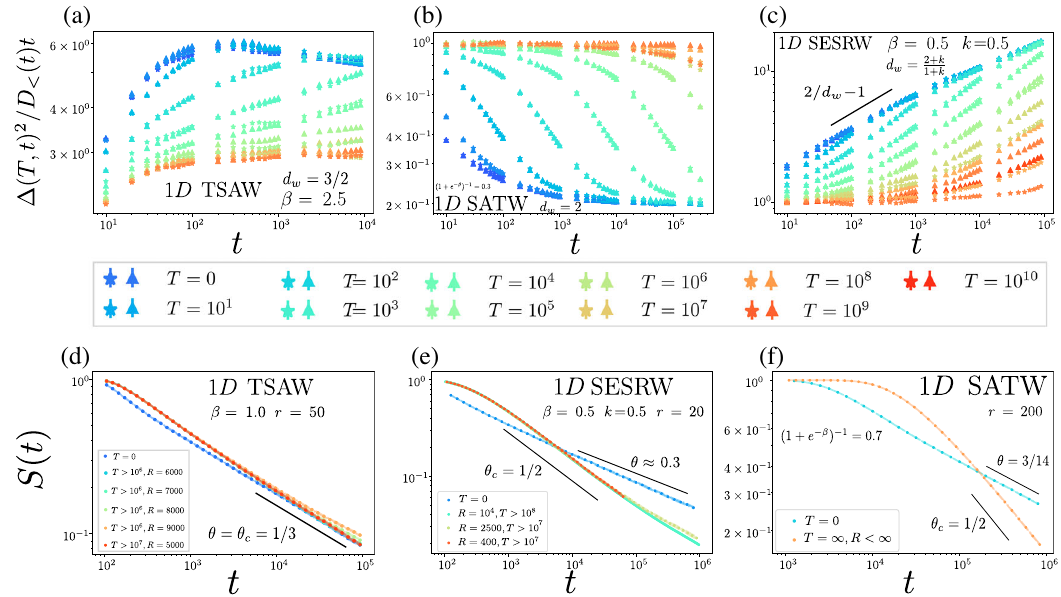
FIG. 3. Aging and first-passage properties for compact self-interacting random walks in infinite space and in confined geometries. (a) Aging of the increments for the 1 d TSAW, (b) the 1 d SATW, and (c) the 1 d SESRW in both infinite space and confined domains (increments are normalized by the expected scaling for T ≫ t ). The dynamics is found to be identical in infinite space (triangle) and in confined domains (stars) in both regimes t; T ≪ R d w and T ≳ R d w ; t ≪ R d w . This is shown by the collapse of triangles and stars for each color, which overlap. The TSAW is superdiffusive at all timesscales and displays aging; the SATW is diffusive at all timesscales and 2 þ k Þ = ð k þ 1 Þ . Persistence displays aging. In contrast, the SESRW is diffusive for T ≫ t , but superdiffusive for t ≫ T with d w ¼ ð exponents in infinite space ( θ ) and in confined domains ( θ ) for (d) the 1 d TSAW, (e) the 1 d SESRW, and (f) the 1 d SATW. The persistence c exponent is modified by confinement for the SATW and the SESRW models but is numerically found to be unchanged for the